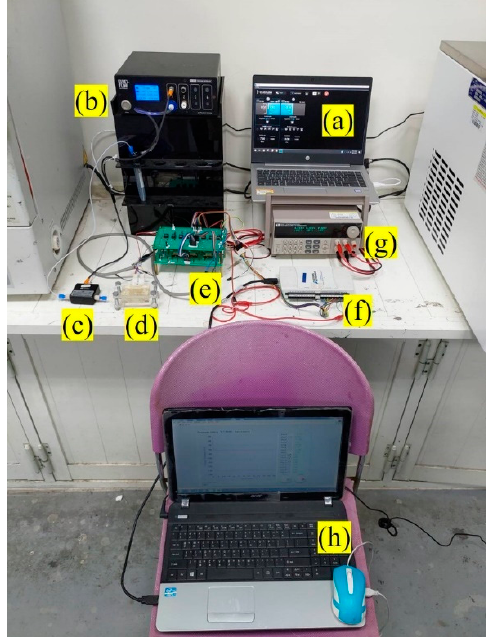
Figure 5. V-T measurement system integrated with microfluidic system ( a ) ELVEFLOW software, ( b ) OB1 MK3 + flow controller, ( c ) microfluidic flow sensor, ( d ) microfluidic channel, ( e ) readout circuit, ( f ) data acquisition, ( g ) power supply, and ( h ) computer with LabVIEW 2012 system.